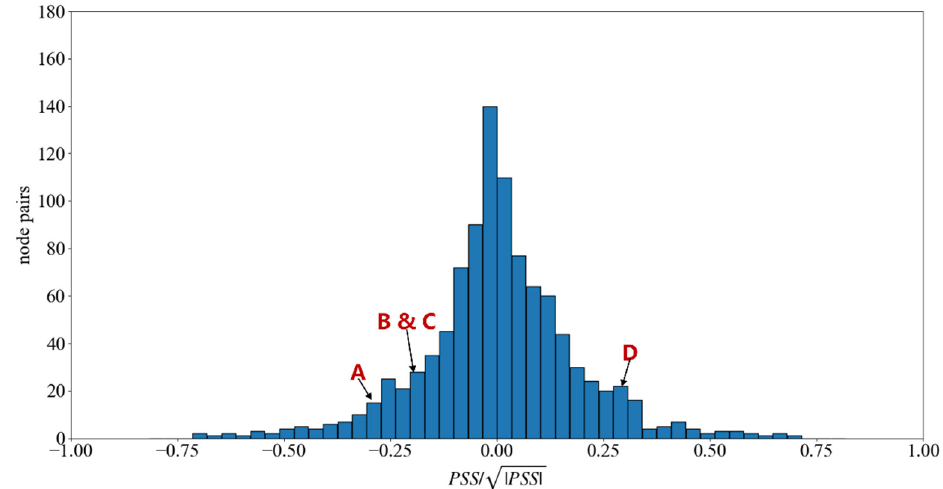
Figure 17. Path selectivity index PSS normalized histogram (A, B, C and D respectively corresponds to the four conditions in Figure 14.).